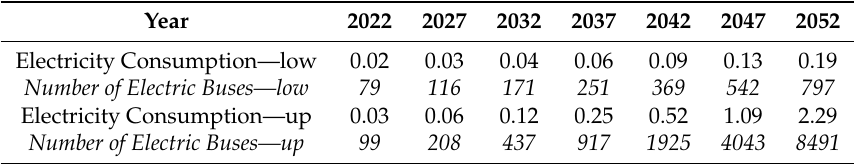
Table 3. BASE scenario electricity consumption bounds for Electric Buses